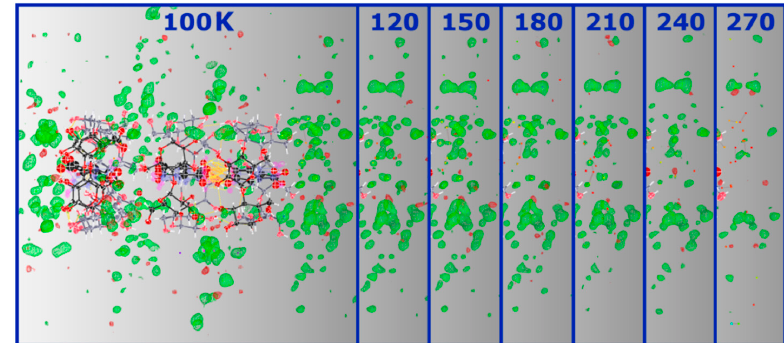
Figure 6. SHELXLE F obs - F calc maps (at 0.40 e − /Å 3 ) of α -CD ∙ SA inclusion complex at 100 K and the respective solvent region at the bottom (right-hand side in the picture) of the vase-like cluster at the different temperatures showing the decrease of the signal as a function of increasing temperature. A similar decrease, not shown here, is observed for the other side.